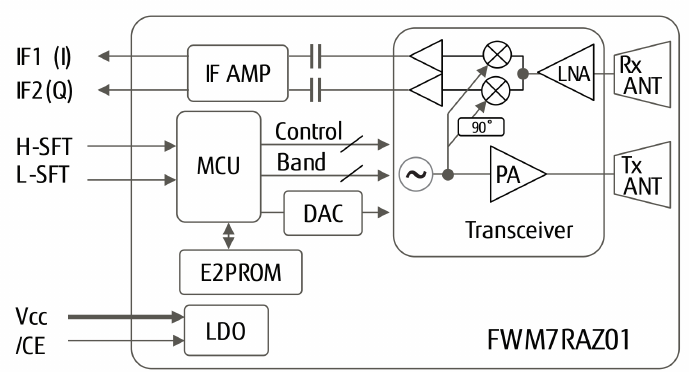
Figure 2. Functional block diagram of FWM7RAZ01 radar sensor